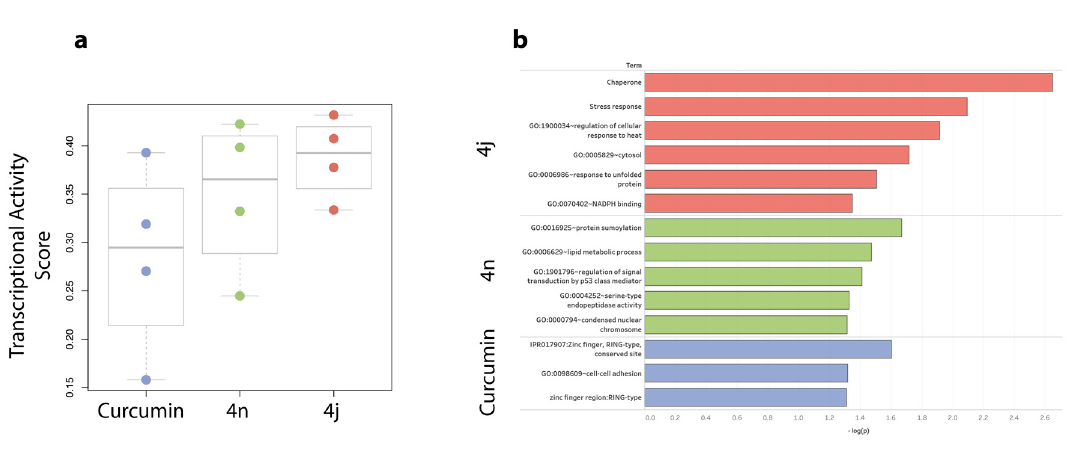
Figure 5. Bis-chalcone 4j elicits a high transcriptional response. ( a ) GSCs Glio9, Glio11, Glio14 and Glio38 were treated with 2.5 µ M bis-chalcone 4j, 4n or curcumin for 24 h; RNA was collected and processed by the L1000 Platform. The Transcriptional Activity Score (TAS) for each condition was calculated from the resulted L1000 gene expression data; ( b ) Bis-chalcone 4j induces a transcriptional signature consistent with ER stress. For each compound, a Transcriptional Consensus Signature was calculated from the L1000 gene expression profiling data and subjected to functional enrichment analysis using DAVID.